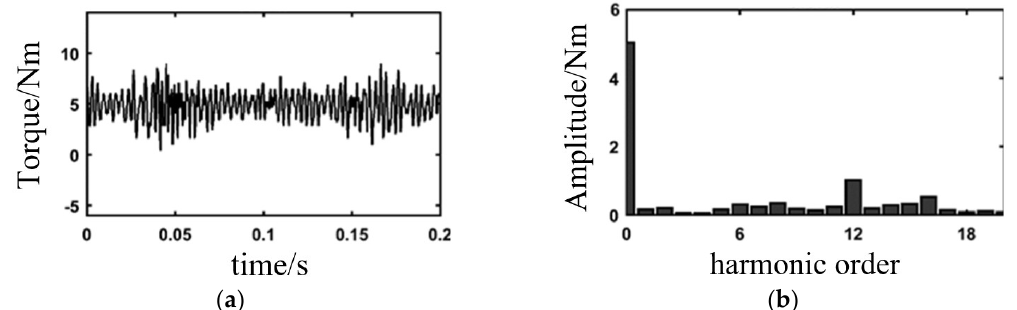
Figure 8. Experiment results without feedforward controller. ( a ) Torque wave; and, ( b ) FFT analysis of torque wave.